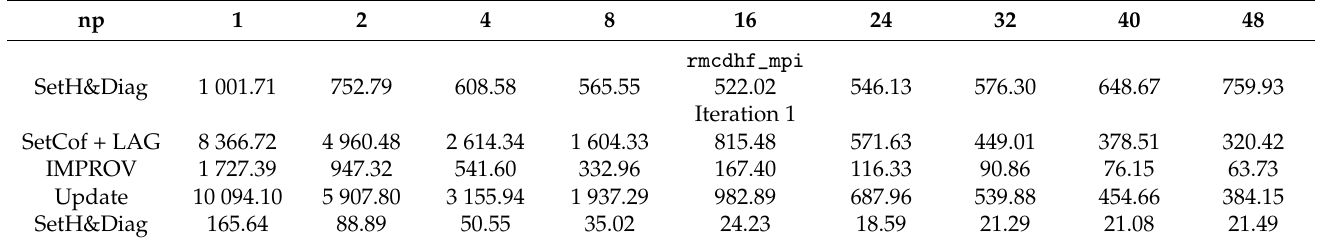
Table 2. CPU times (in s) for the Mg VII AS 3 SCF calculations using the rmcdhf_mpi , rmcdhf_mem_mpi and rmcdhf_mpi_FD codes as a function of the number of MPI processes ( np ). See text for the label